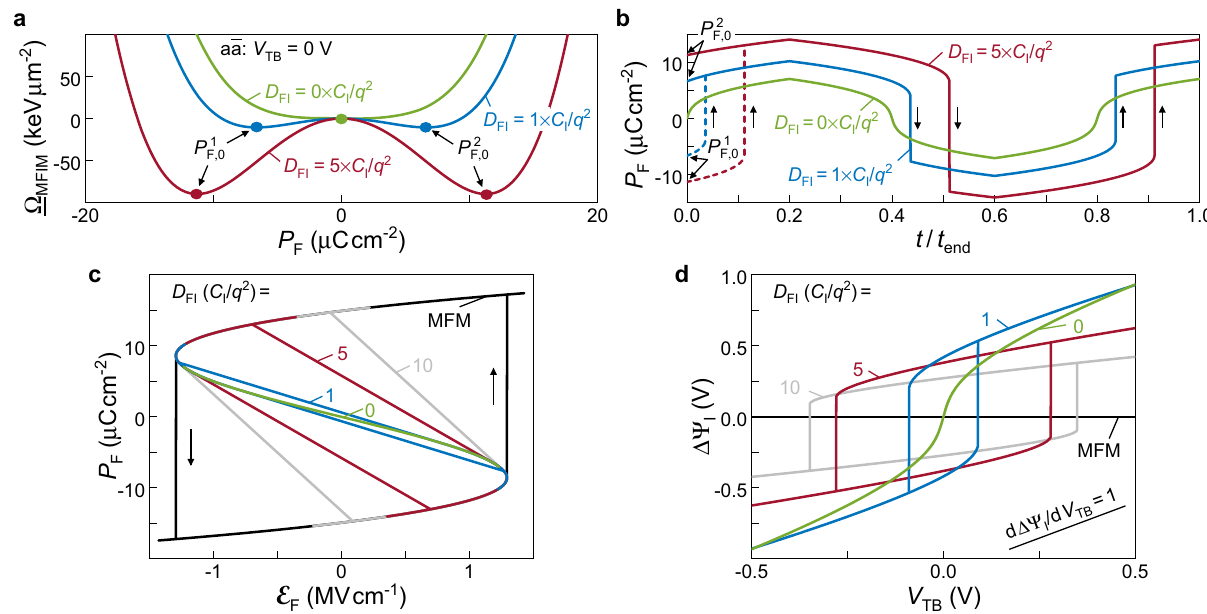
Fig. 3 Surface charge density at the ferroelectric-insulator interface results in increased hysteretic device operation of the free-charge-conducting metal-ferroelectric-insulator-metal ( c -MFIM) system. a The Grand Potential energy ( Ω MFIM ) landscape of the c -MFIM system (see (Fig. 1a) is plotted along the trajectory (aa) of constant applied voltage V TB = 0 V for different values of the interface state density D FI . The constant- V TB trajectories for D FI = 1 × C I / q 2 and D FI = 5 × C I / q 2 , where C I is the capacitance of the insulator layer and q is the electron charge, are indicated in (Fig. 2. For each case, the stable ferroelectric polarization states are indicated with solid circles. For D FI = 0, the c -MFIM system has a single stable state with ferroelectric polarization P F = 0. However, increasing the interface state density D FI deforms the Grand Potential energy landscape. As a consequence, for larger D FI , the c -MFIM system is characterized by two distinct stable states with non-zero polarization ( P 1 and P 2 ). b Quasi-static P F - t simulation results show that increasing D FI F ; 0 F ; 0 results in abrupt switching of the ferroelectric polarization P F . (The dashed and solid curves correspond to quasi-static simulations with different initial polarization states ( P 1 or P 2 ) of the system). c The P F - E F characteristics, where E F is the electric fi eld strength in the ferroelectric layer, and d ΔΨ I - V TB F ; 0 F ; 0 curves, where ΔΨ I is the electrostatic potential difference over the insulator layer, demonstrate the appearance and subsequent worsening of hysteretic device operation with increasing interface state density D FI . The case of D FI = 0 corresponds to the intrinsic MFIM system (Supplementary Fig. S3) and D → ∞ to the metal-ferroelectric-metal (MFM) system (Supplementary Fig. FI